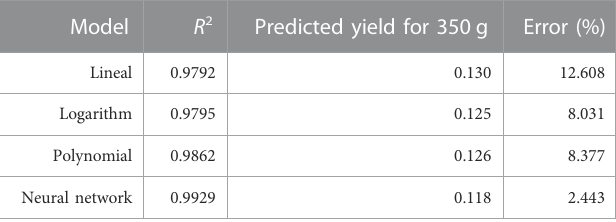
TABLE 3 Neuron network prediction capabilities against other common